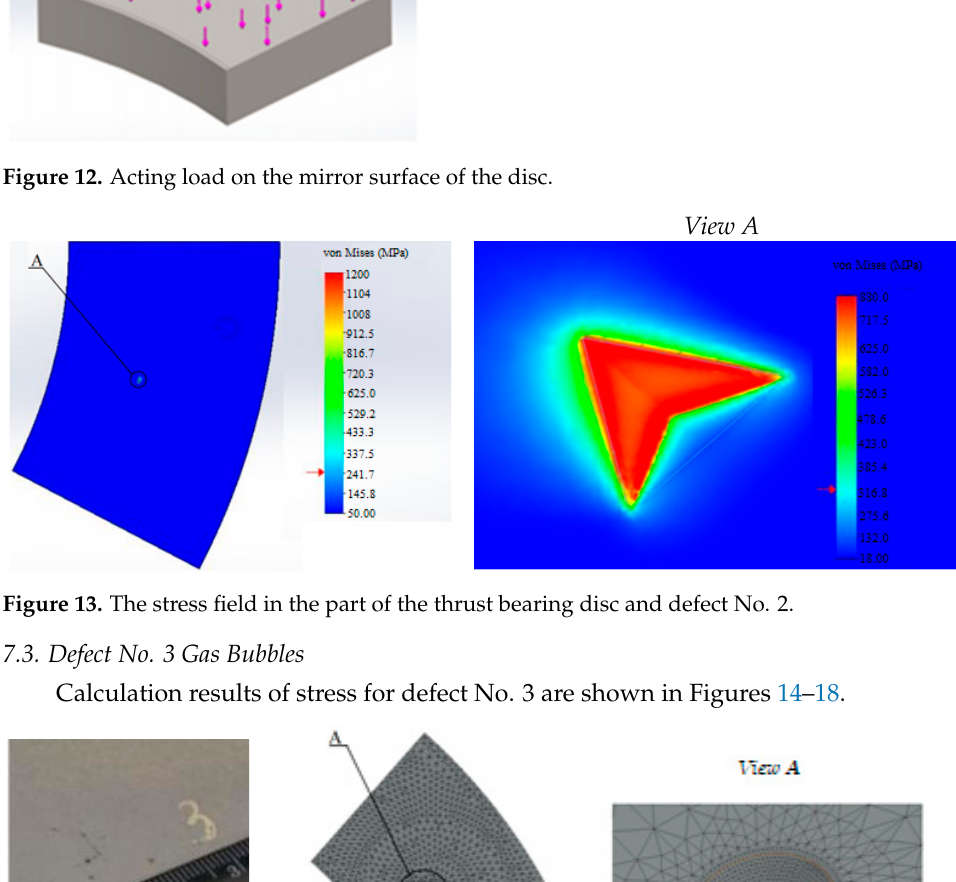
Figure 11. Conditions of the disc fastening.